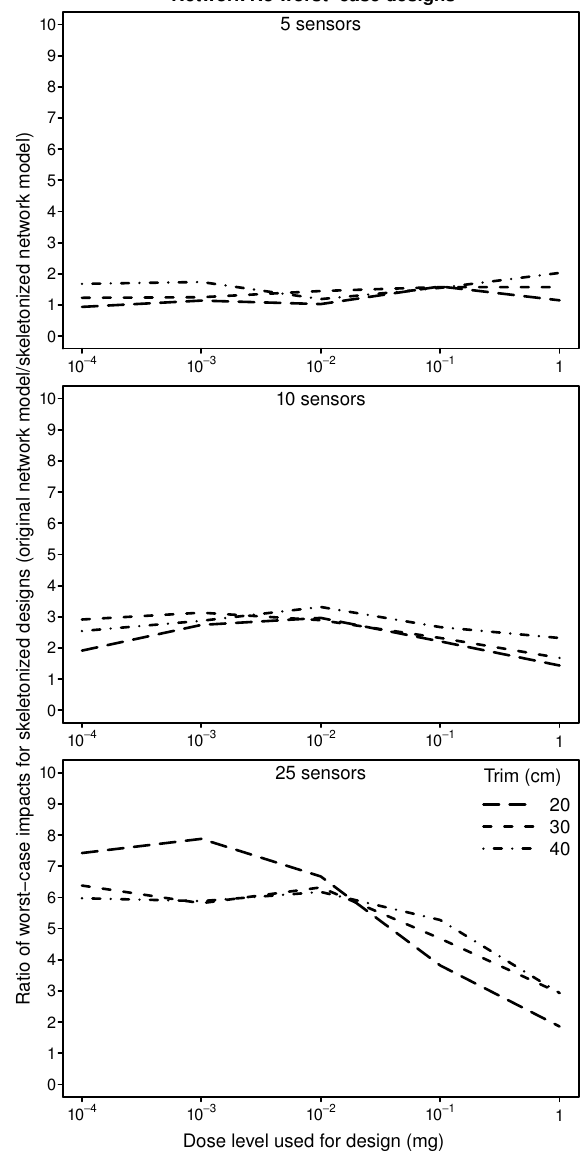
Figure 6. Relative worst-case impacts for transplanted and non- transplanted worst-case CWS designs for Network N3. Results are shown for three levels of network skeletonization